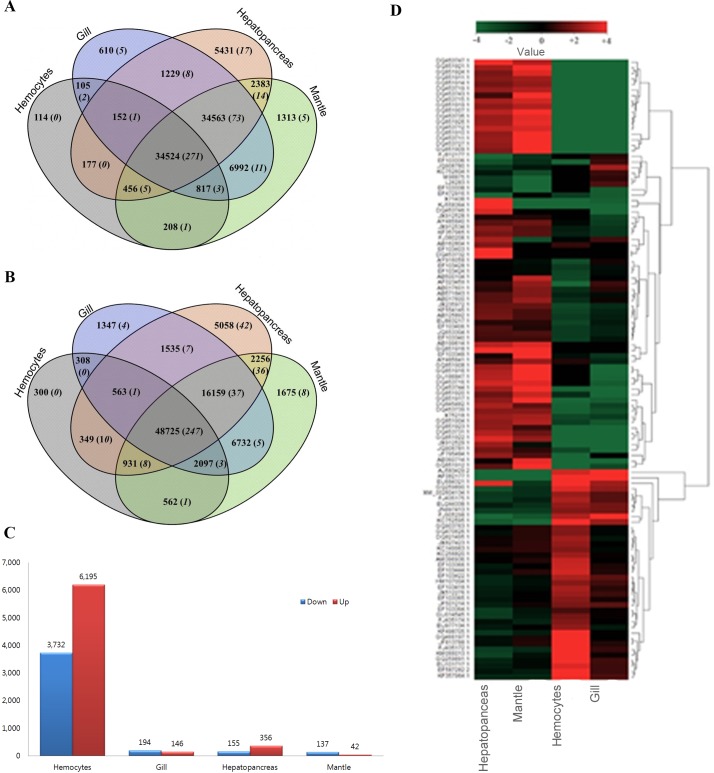
Differentially expressed genes (DEGs) upon V. parahemolyticus infection.Venn diagrams show DEGs of (A) non-infected and (B) V. parahemolyticus infected. The numbers shown in brackets correspond to the nucleotide sequences available in GenBank. (C) Tissue specific histogram of up and down regulated transcripts. (D) Heat map of transcripts with expression change more than 2-fold in each tissues.